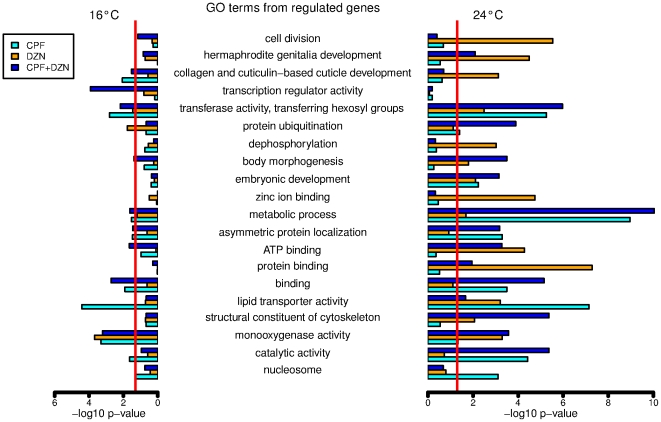
Highly significant Gene Ontology (GO) enriched terms from differentially expressed genes in CPF, DZN and CPF+DZN combination treatments at 16°C and 24°C.As a summary from GO analysis, highly significant (p-value  = 0.001, hypergeometric test) enriched GO terms in at least one treatment were selected and the p-values of those GO terms in all treatments were plotted. The full list of GO terms and the corresponding GO ID numbers can be found in Table S3. Each bar identified a treatment: CPF (cyan), DZN (orange) and a combination of both (blue). Left side bars for 16°C treatments and right side bars for 24°C treatments.